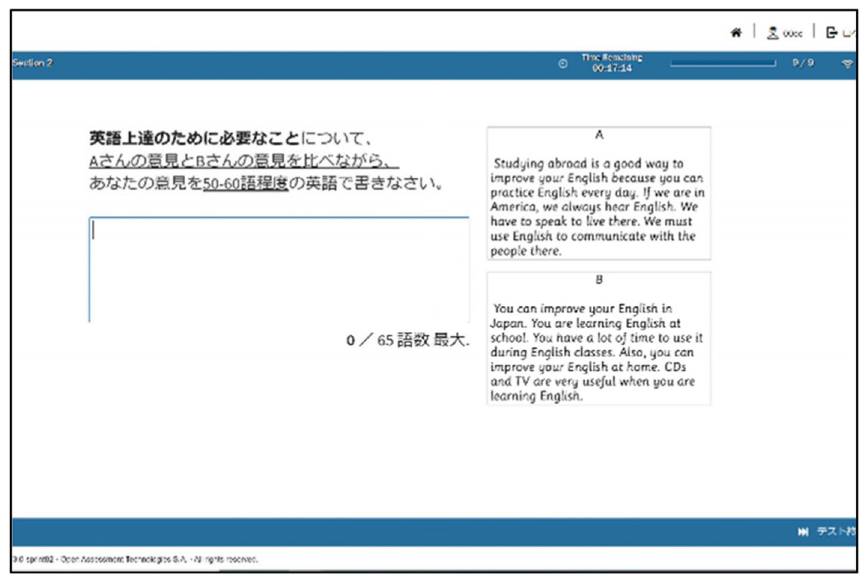
Fig. 8 Screen 7: State your ideas logically in